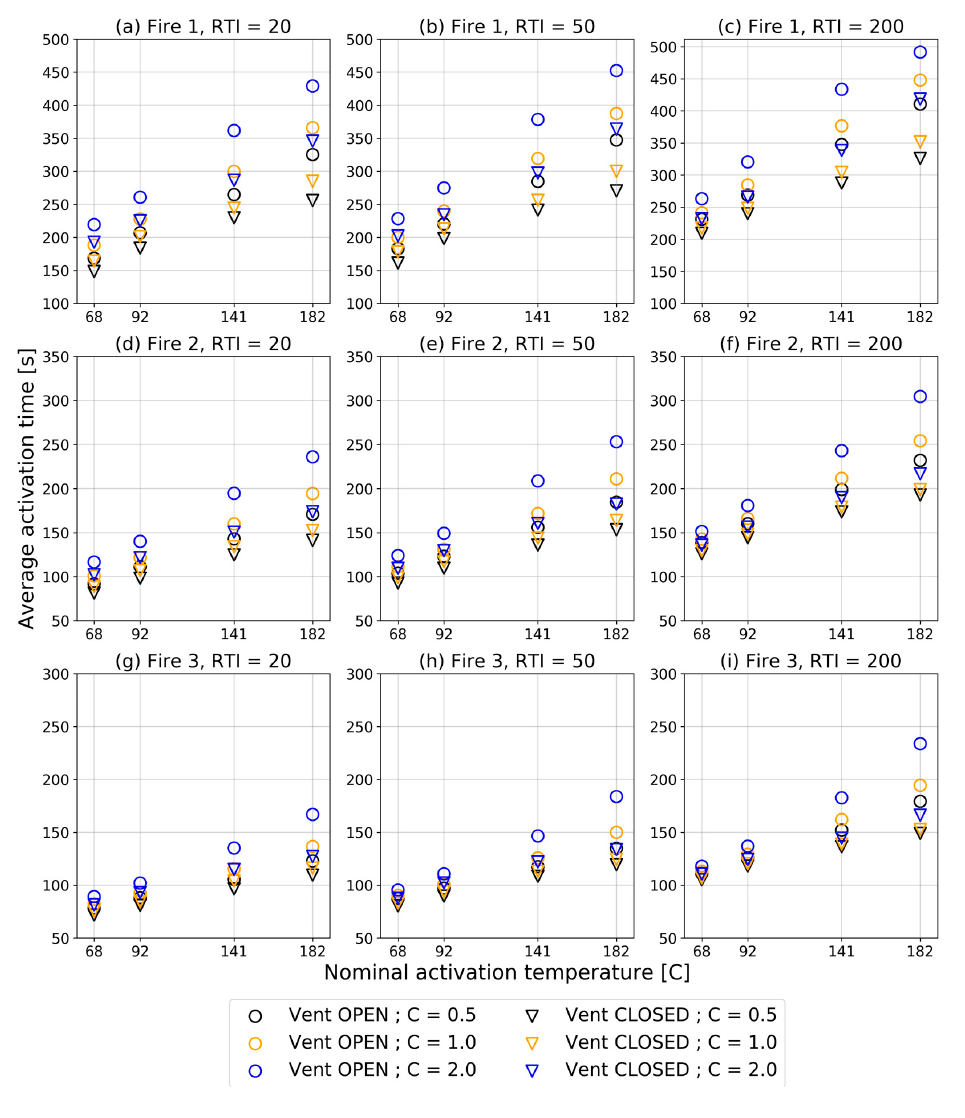
Figure 6. Average time of sprinkler activation (s) within the predefined region (Figure 4) for all performed simulations. Different plots ( a–i ) represent different Fire scenarios (1-3) and different RTI values (20, 50 and 200), as described in the title above each plot